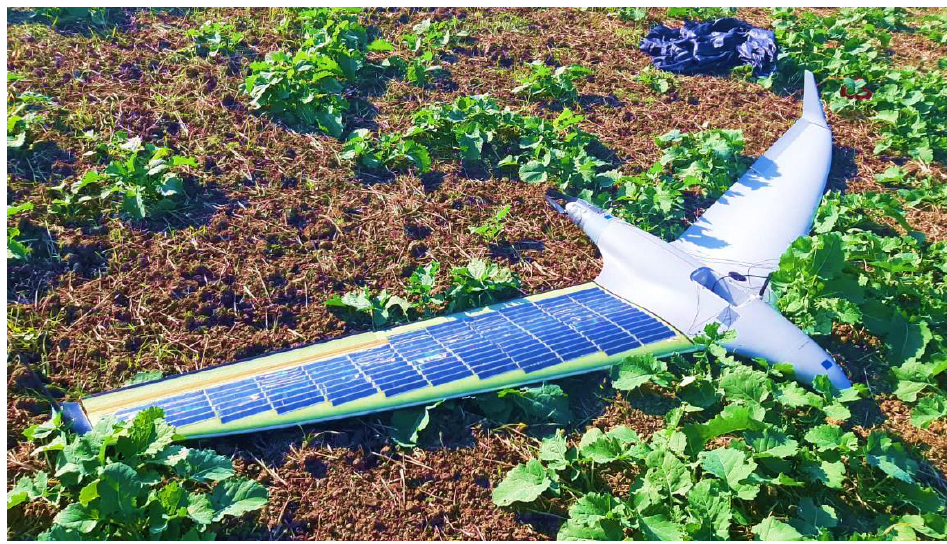
Figure 14. Photo of the UAV prototype.